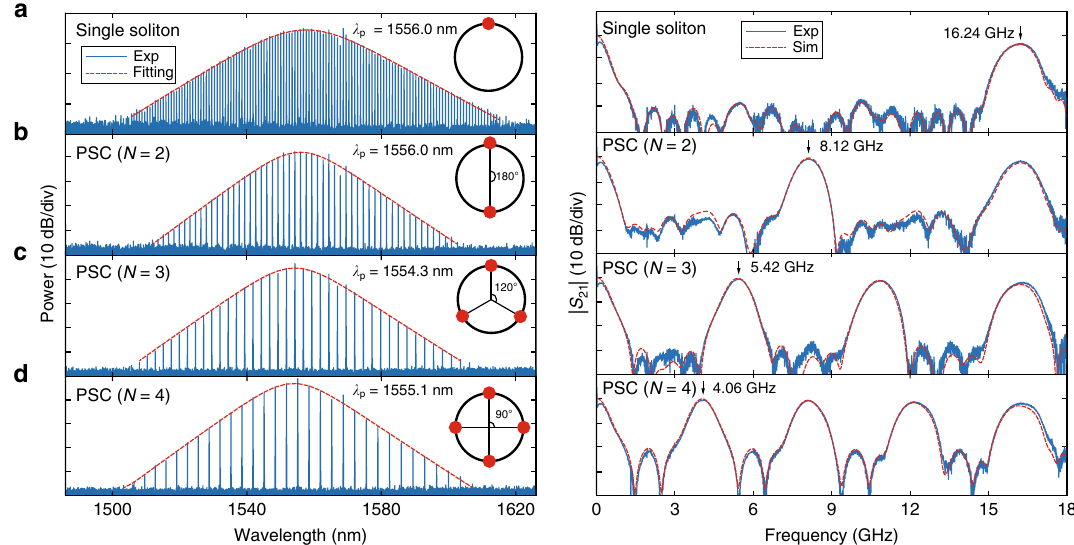
Fig. 2 Single-soliton/PSC spectra and their corresponding RF photonic fi lters. Through deterministic accessing PSC states of different resonances, the RF fi lter passbands can be divided correspondingly. Left column: microcomb spectra (blue: experiment; red: sech 2 fi tting); right column: corresponding normalized RF fi lter responses (blue: experiment; red: simulation). a RF fi lter centered at 16.24 GHz based on single soliton from resonance of 1556.0 nm; b – d RF fi lters centered at 8.12, 5.42, and 4.06 GHz based on two , three , four times PSC, generated at resonances of 1556.0, 1554.3, and 1555.1 nm, respectively. The insets of left column illustrate soliton distribution inside the microresonator: a single-soliton; b – d equally spaced solitons (PSCs) with adjacent angles of 180°, 120°, and 90°, respectively (360°/ N , N = 2, 3,